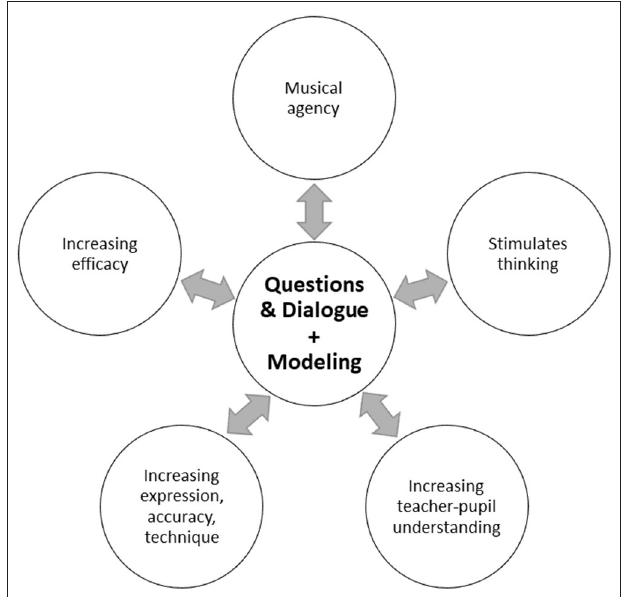
FIGURE 5 | Potential effects of a dialogic teaching approach on various aspects of the teaching-and-learning process.